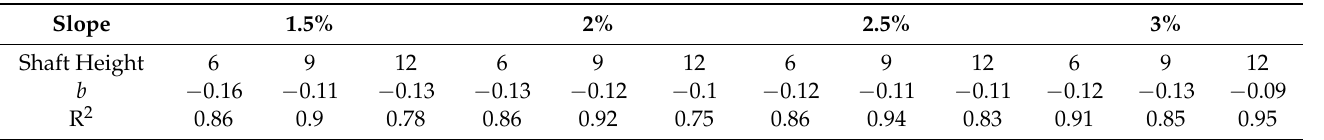
Table 3. Fitting coefficients of the dimensionless relation between inlet air velocity and fire source location ( L f >